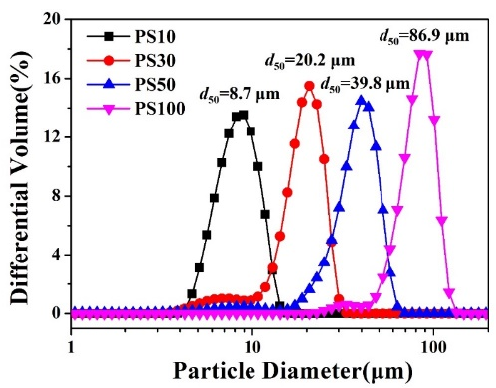
Figure 3. Particle distribution of the PS10, PS30, PS50 and PS100.